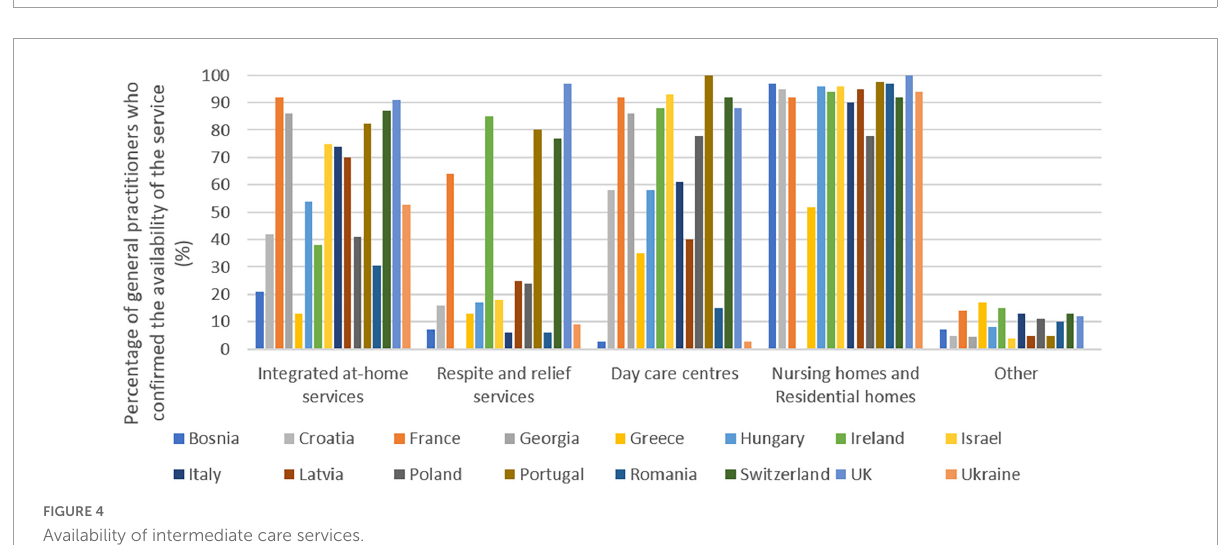
FIGURE4 Availability of intermediate care